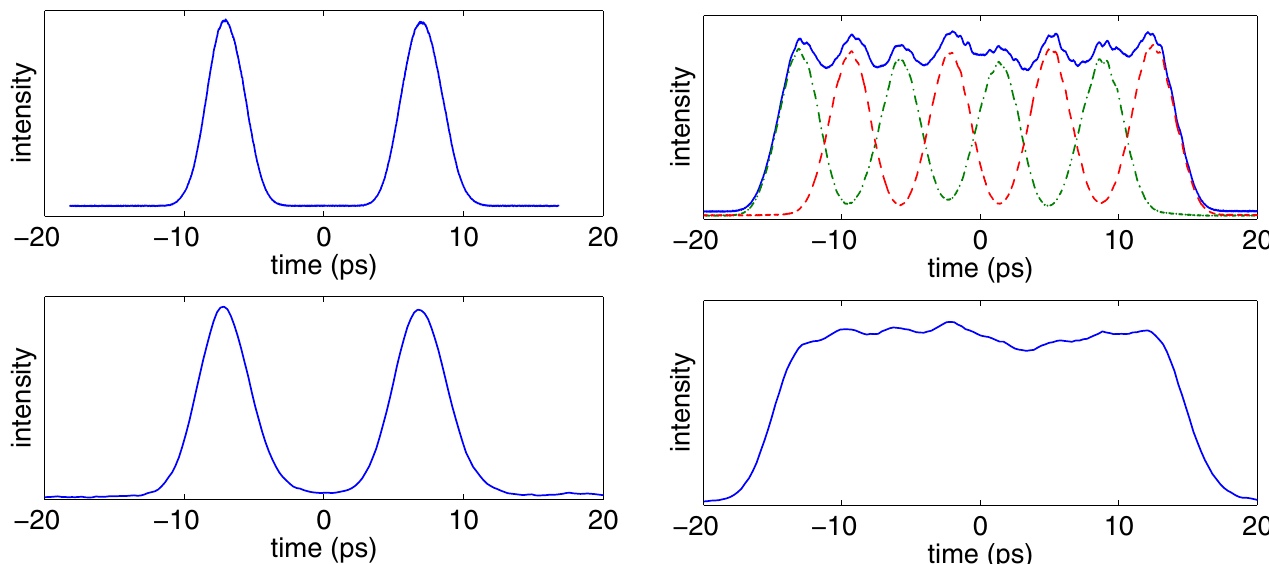
FIG. 5. (Color) Laser pulse (top) and electron bunch (bottom) temporal profile measurement after a single (longest) shaping